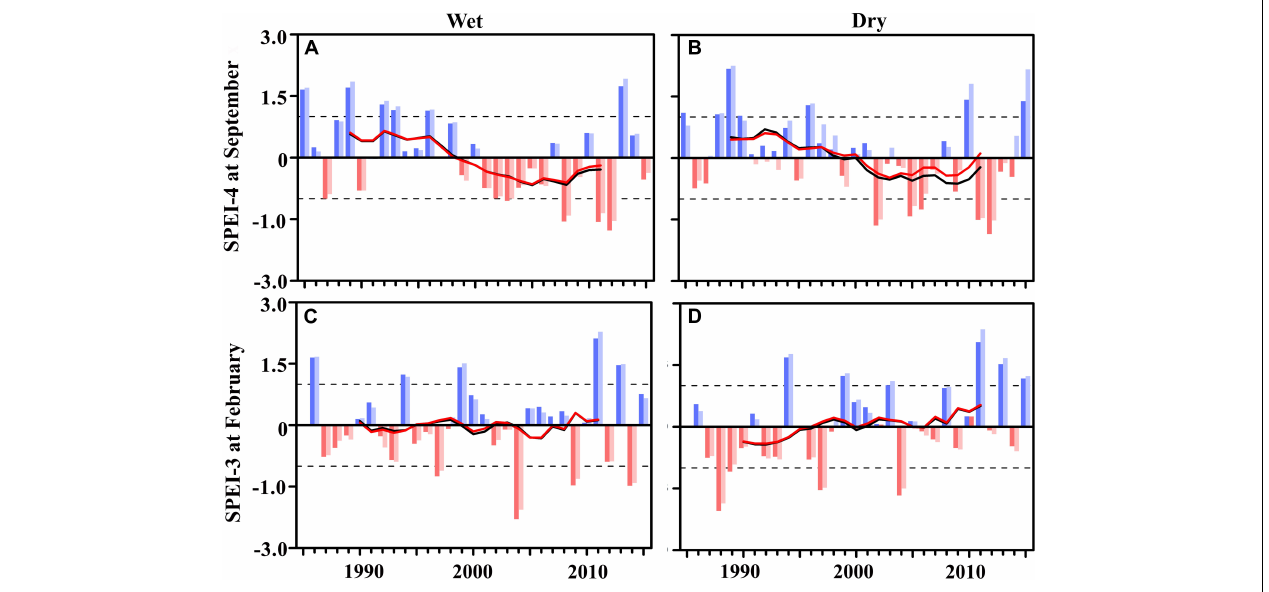
FIGURE 7 | Time series of SPEI and SPI during the southwest monsoon season (SPEI-4/SPI-4 at September) for (A) the wet and (B) dry regions in Mahaweli river basin (MRB) from 1985 to 2015. The lower panels (C,D) are the same as top panels, but for the northeast monsoon season (SPEI-3/SPI-3 at February). The positive and negative SPEI (SPI) values are shown by blue (light blue) and pink (light pink) colored bars, respectively. The red (black) line indicates a 9-year running mean of the seasonal SPEI (SPI) time